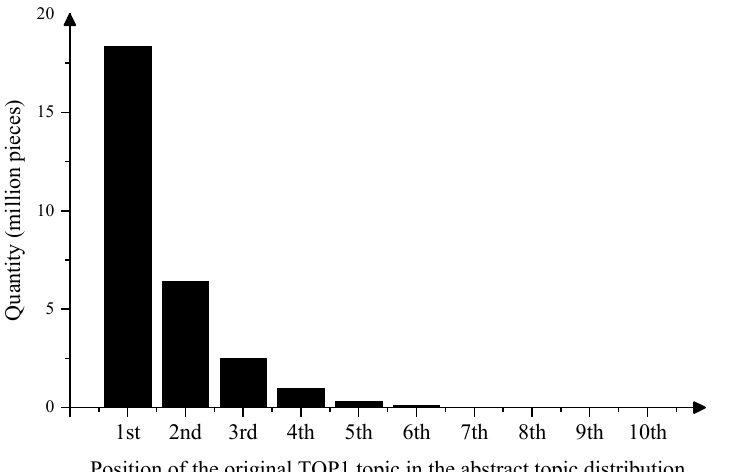
Position of the original TOP1 topic in the abstract topic distribution Figure 1. Distribution of original text TOP 1 topics in summary topics. The horizontal axis is the order of the original text TOP 1 topics in its summary topic, and the vertical axis is the number of the original text TOP 1 topics in summary topic distribution.